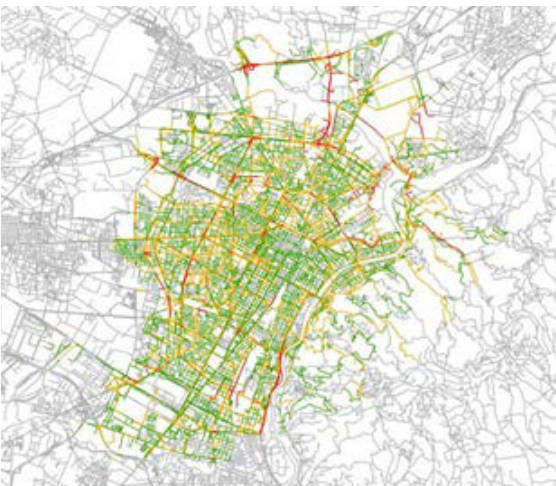
Figure 1. Vehicle density during morning rush hour estimated from FCD